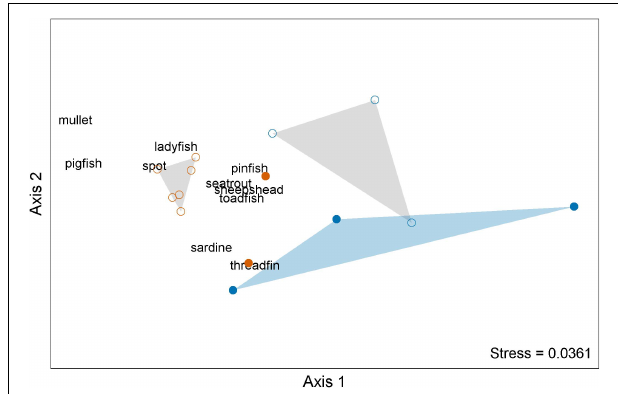
FIGURE 4 | Non-metric multidimensional scaling (NMDS) ordination of prey assemblage structure based on month, season, and bloom condition